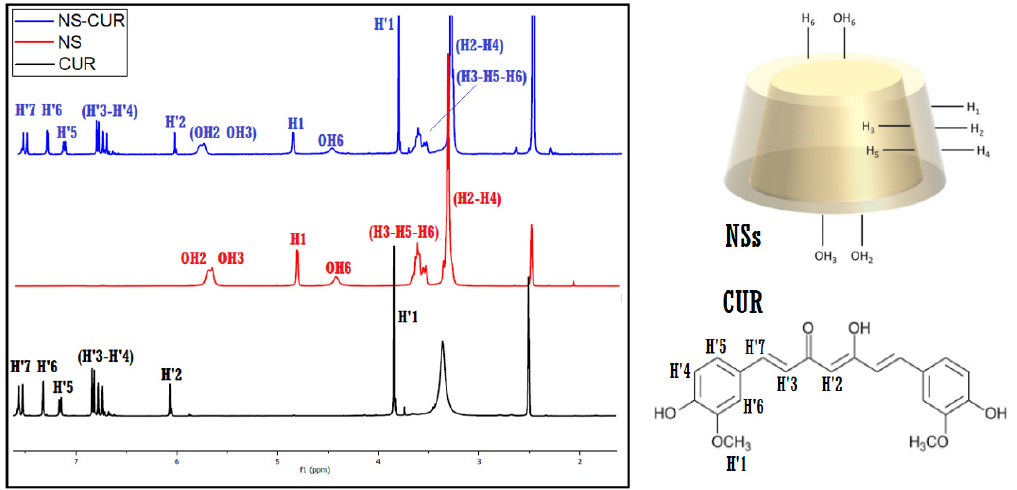
Figure 4. 1 H-NMR spectra (400 MHz, DMSO-d 6 ) of CUR, NSs, and NSs–CUR.